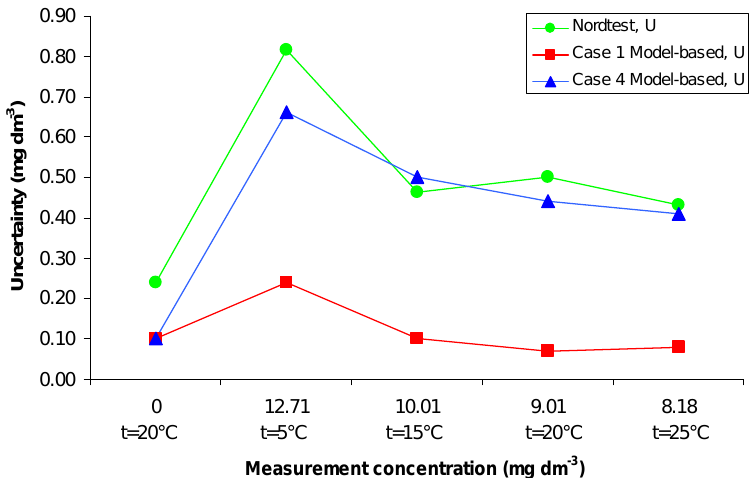
Figure 2. Expanded uncertainties for all conditions using two estimation